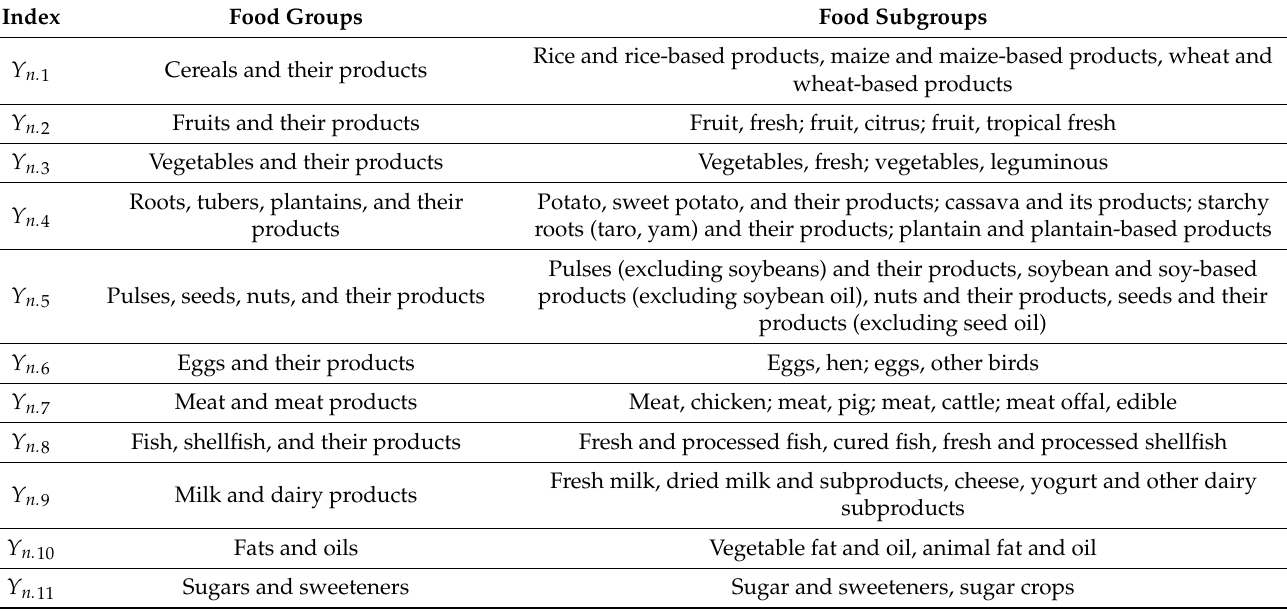
Table 3. Regressands and corresponding food group classifications used in the